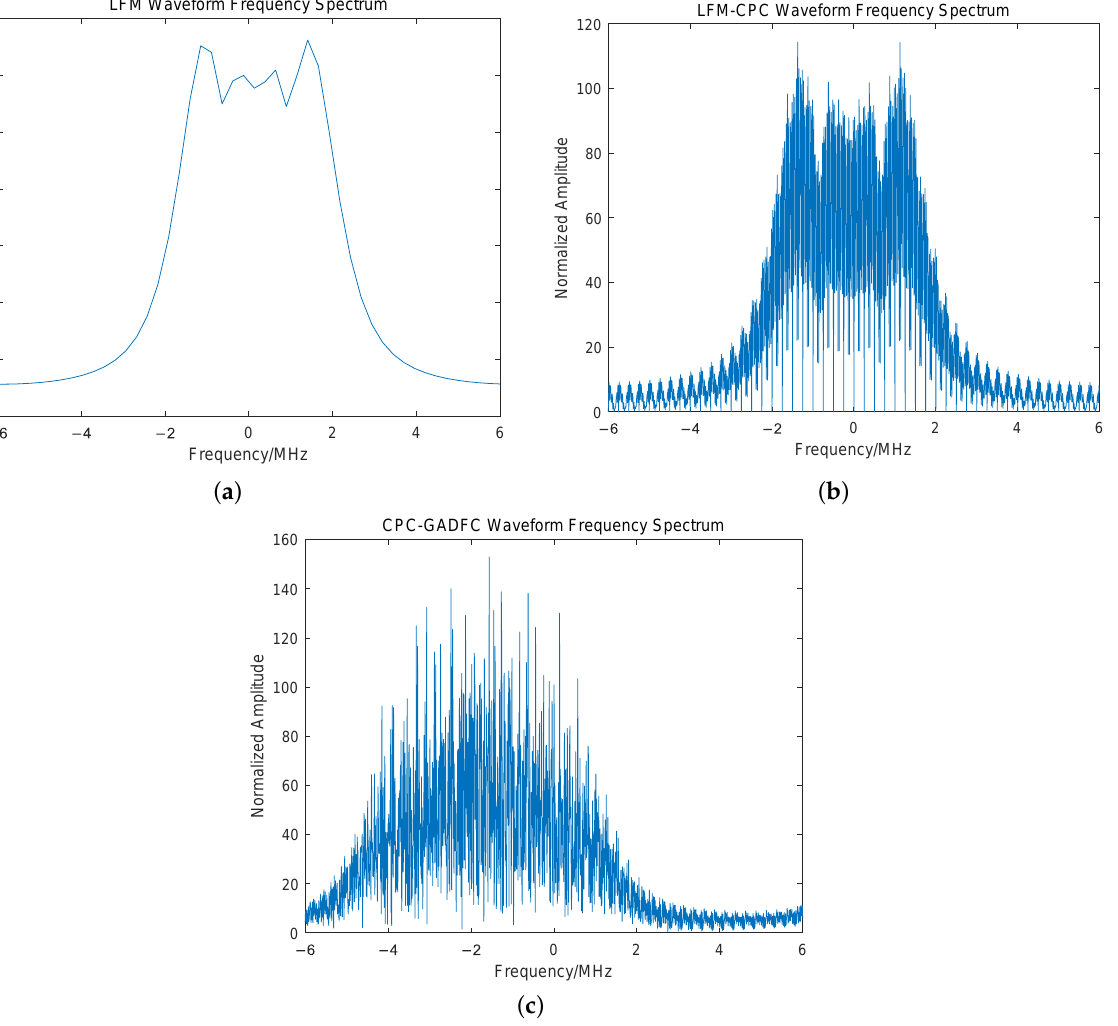
Figure 7. Spectrum comparison of waveform single pulse, ( a ) the LFM waveform spectrum, ( b ) the LFM-CPC waveform spectrum, ( c ) the CPC-GADFC waveform